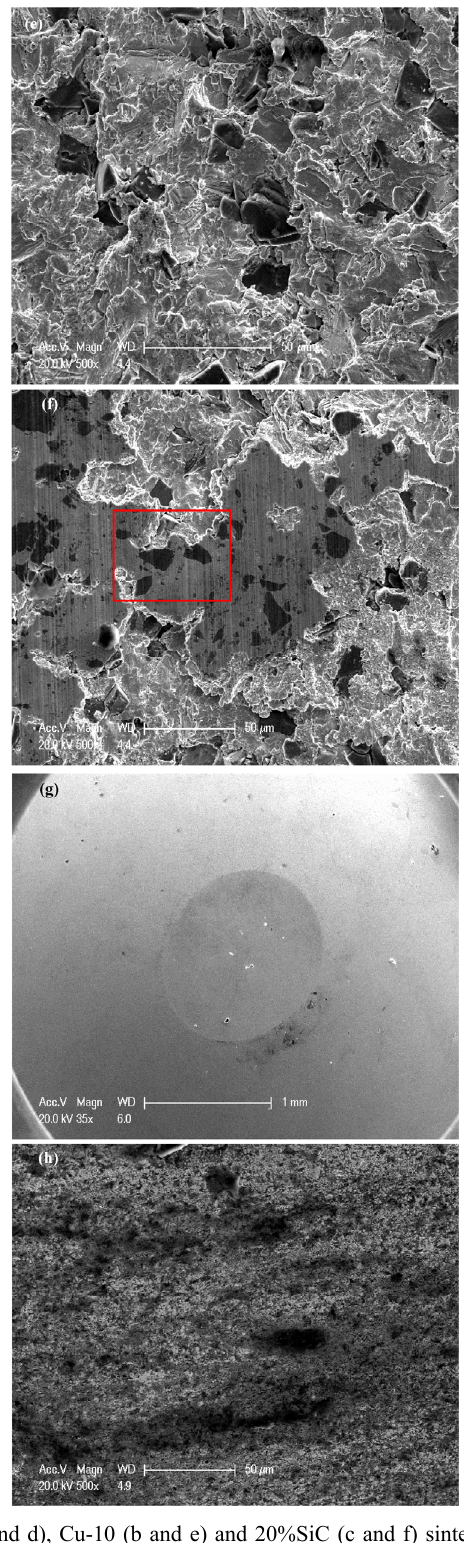
Fig. 12 SEM photograph of the worn surface morphology of Cu (a and d), Cu-10 (b and e) and 20%SiC (c and f) sintered samples corresponding to a sliding distance of 2,500 m and applied loads of 5 N (a–c) and 30 N (d–f) , and (g–h) the corresponding WC wear surface morphology after the sliding against Cu-20%SiC sintered sample under sliding distance of 2,500 m and an applied load of 30 N under different